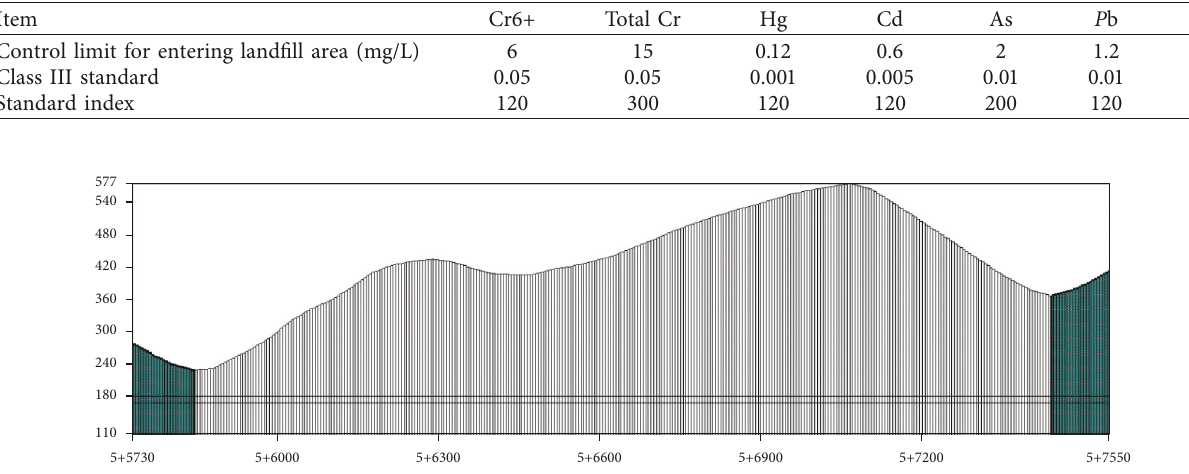
Table 1: Predictor identification.